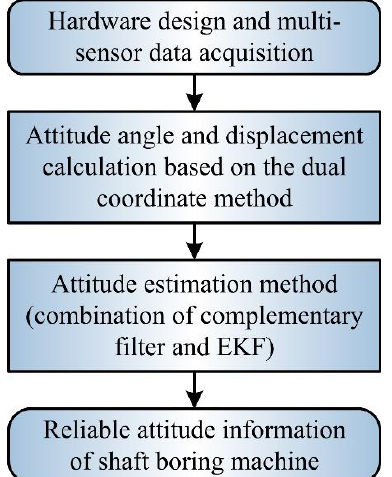
Figure 2. Block diagram of multi-sensor fusion and error compensation.